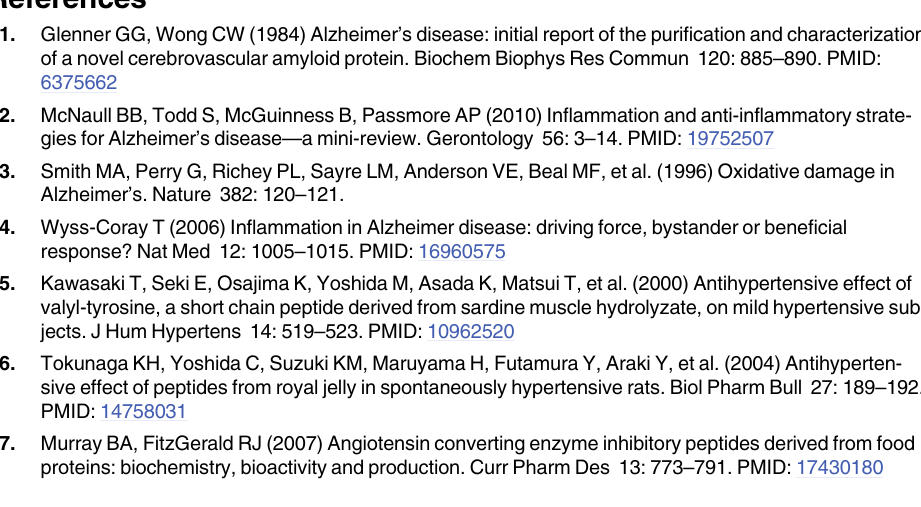
orally administered to mice every day at 0.5 mg/kg/day starting 2 days before PBS injection. n = 4–5 mice in each group. S3 Fig. Effect of test reagents on cognitive function of PBS-injected mice. Swim latency in Morris water maze test. CH-3 (250 mg/kg/day) or MKP (0.5 mg/kg/day), perindopril (1 mg/ kg/day) was orally administered to mice every day starting 2 days before PBS injection. n = 4–6 mice in each group. The data of PBS-injected group mice (n = 4) are the same as the data of S1 Fig. (TIF) S4 Fig. Effect of test reagents on blood pressure of AD model mice and PBS-injected mice. Blood pressure was measured by using a noninvasive computerized tail-cuff system. CH-3 (250 mg/kg/day) or MKP (0.5 mg/kg/day), perindopril (1 mg/kg/day) was orally administered to mice every day starting 2 days before A β 1–42 or PBS injection. n = 4 mice in each group. (TIF) S1 Text. Supporting method of blood pressure measurement.